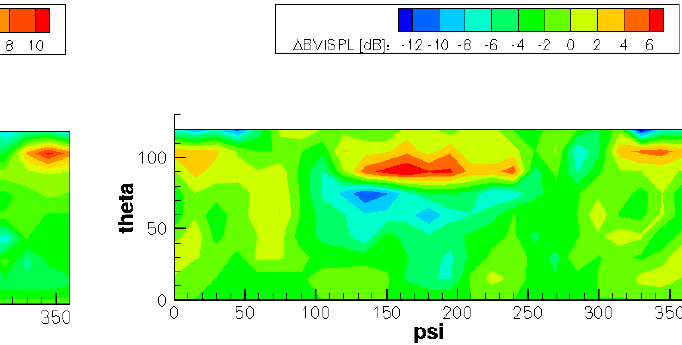
Figure 13: Technique A – B differential BVISPL at point 2 in maneu- ver ID8021.